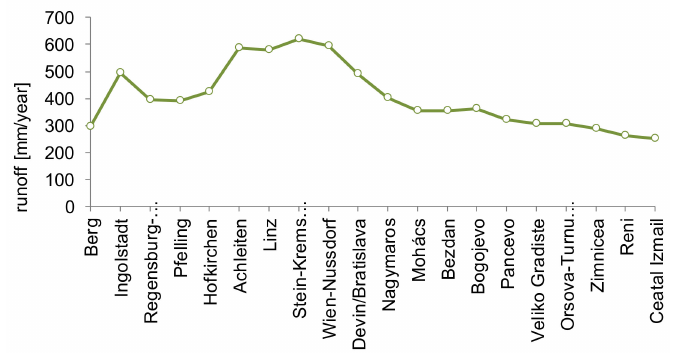
Figure 7. Course of the long-term runoff depth R (mm per year) along the Danube